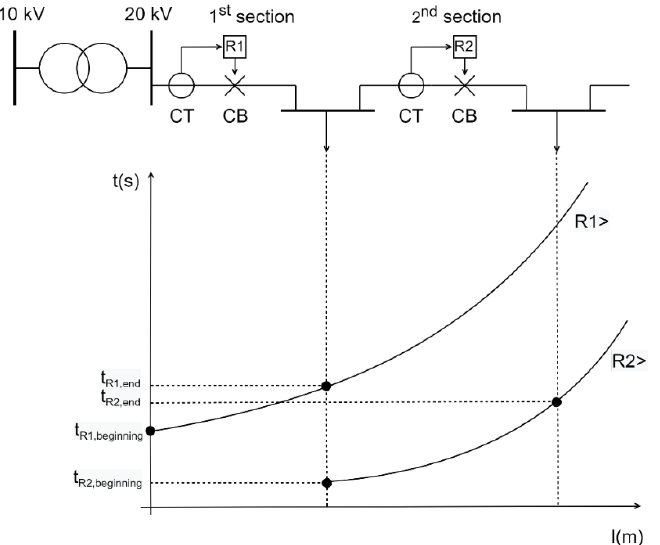
Figure 4. On the minimization of relay operating times at the beginning and the end of the primary protection zone.